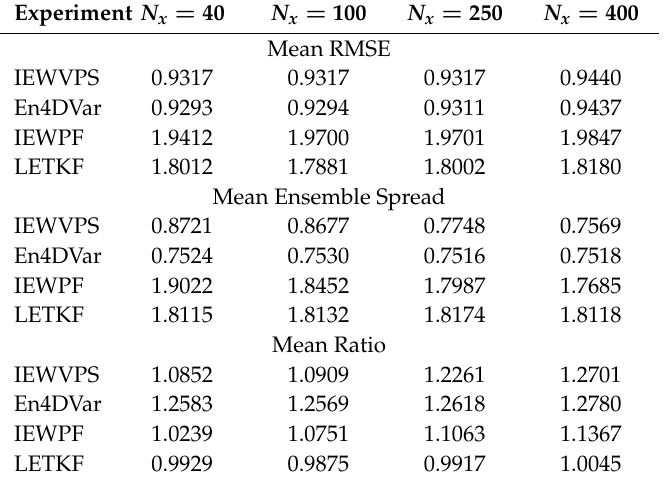
Figure 2. The rank histograms calculated from posterior particles generated by the IEWVPS ( left panel ) and En4DVar ( right panel ) with R = 1.6 I ( top panel ) and R = 0.16 I ( bottom panel ). Ranks are aggregated over all steady-state time steps and all state elements. Table 2. The mean RMSE, ensemble spread, and the ratio of RMSE to ensemble